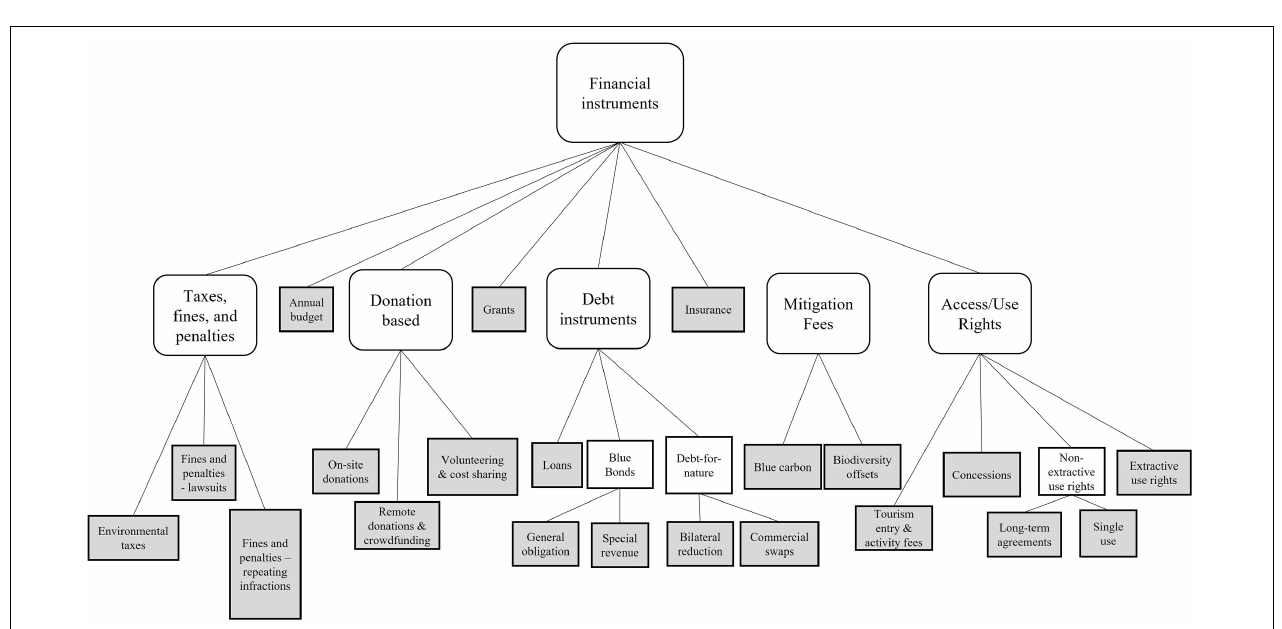
FIGURE 4 | Organizational chart of sources of finance compiled into the review. Sources with individual sets of indicators are represented by shaded ovals.